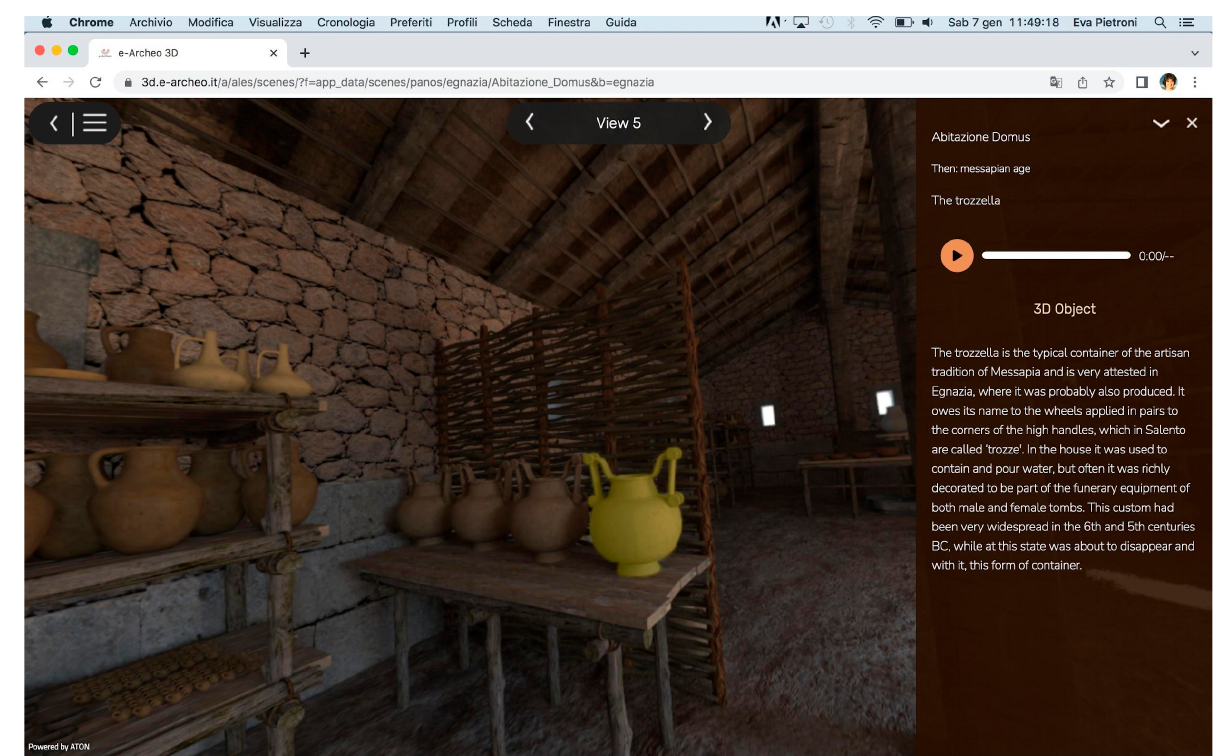
Figure 3. Virtual reconstruction of a domus in Egnazia, with museum objects contextualized.